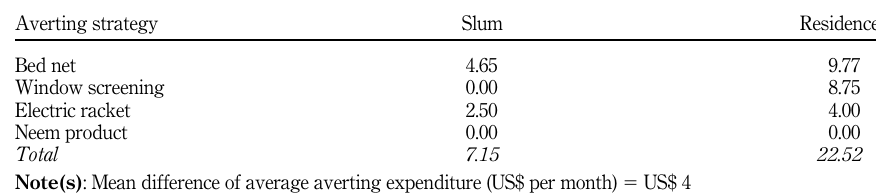
expenditure: US$ per month